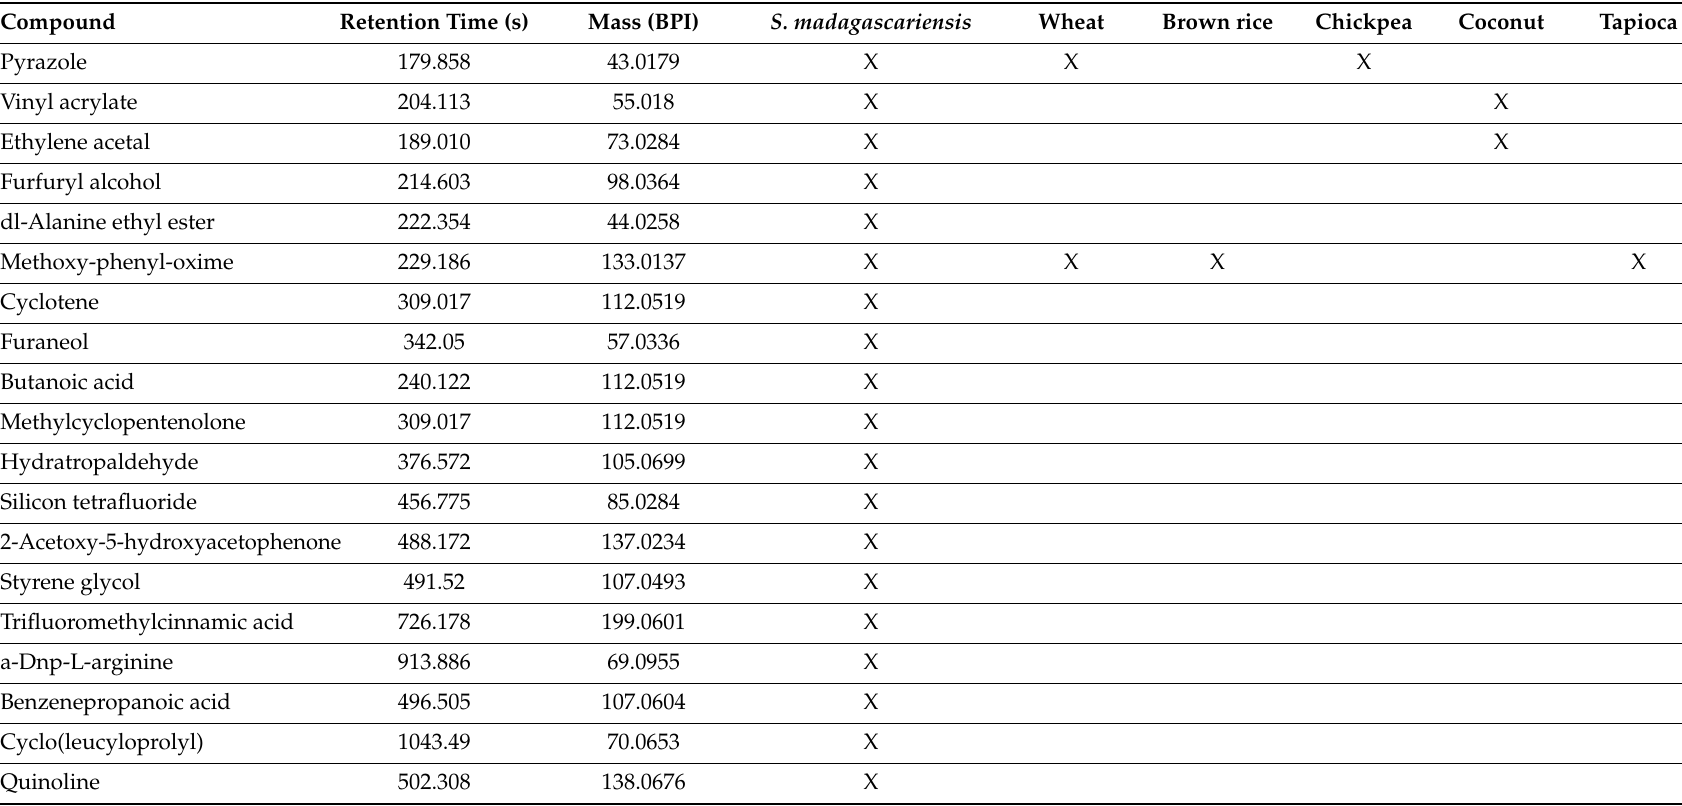
Table 2. Volatile metabolic compounds identified in S. madagascariensis seed flour in reference to the other